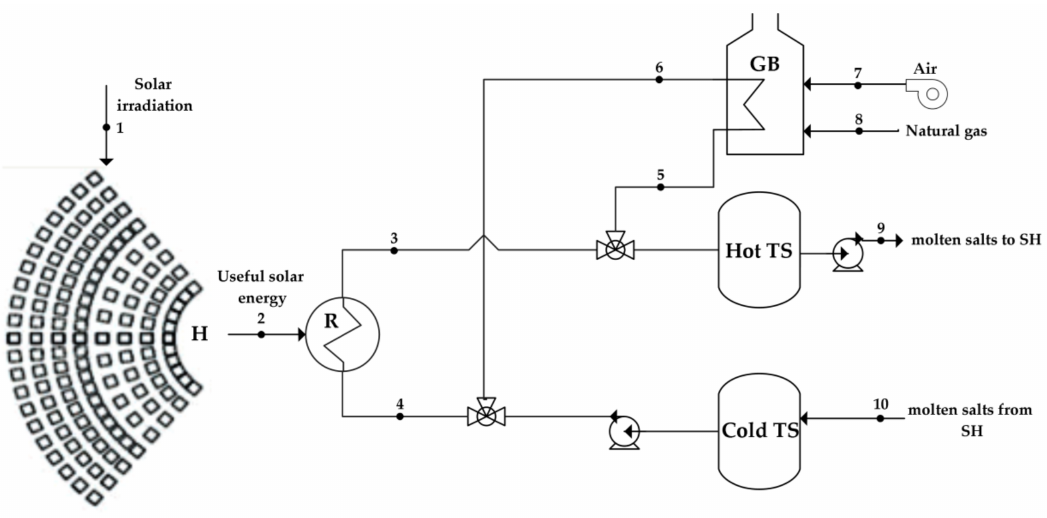
Figure 1. Structure of solar system with heliostats and solar tower: H—heliostats,